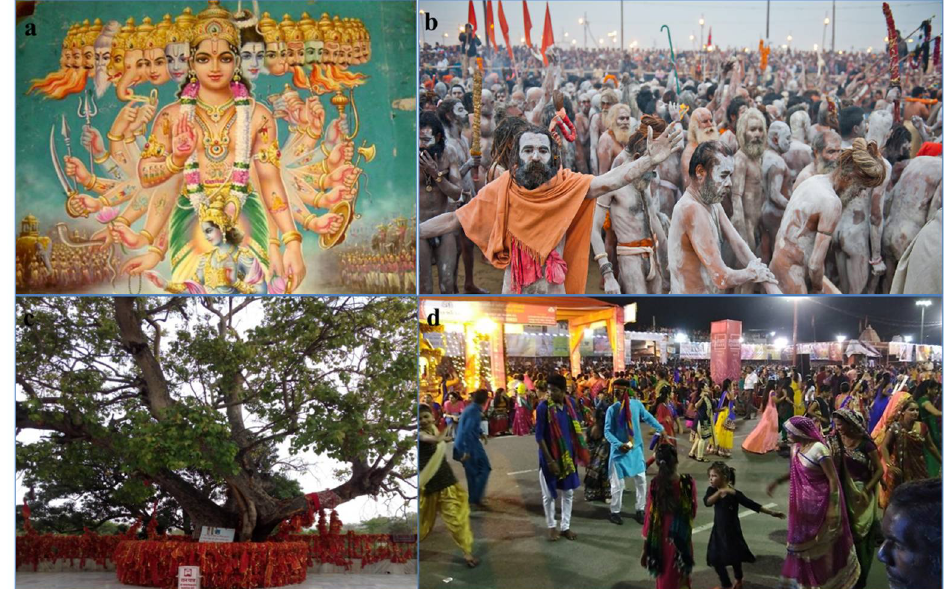
Figure 2. Hinduism has much potential to impart environmentally-friendly practices in people through religious pathways: ( a ) An artist’s image of Vishvarupa god; ( b ) thousands of ascetics (e.g., Naga Sadhus) voluntarily sacrifice the amenities of regular life and reproduction in many shipped by Hindus who avoid cutting these trees; ( d ) religious fasting is prevalent in Hinduism.